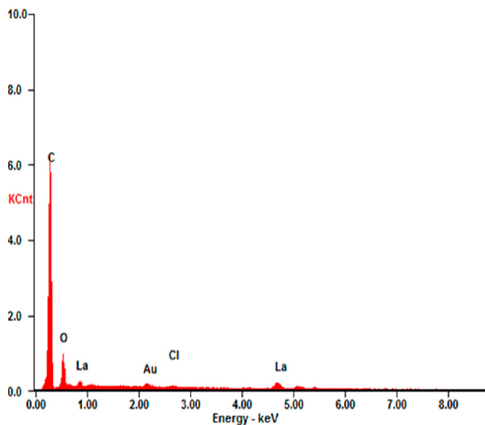
Figure 6. Energy dispersive spectrometer (EDX) spectrum of the superhydrophobic surface obtained by pulse electrodeposition under 60% duty ratio. Table 2. Composition of the as-prepared superhydrophobic surface obtained by EDX.